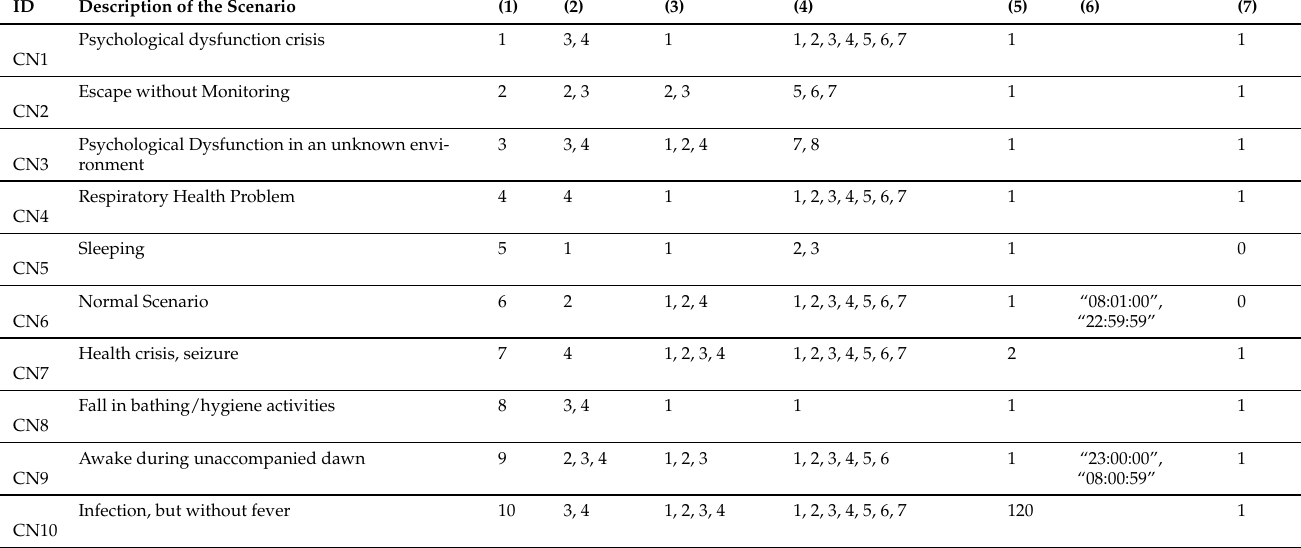
Table 6. Scenarios used to generate DCARE Dataset Simulator